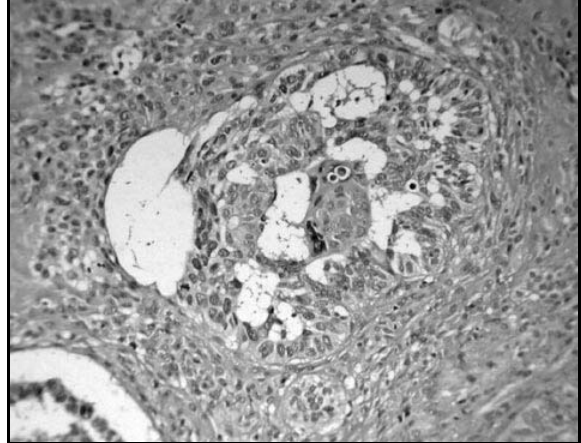
Figura 3 – Detalhe do componente epitelial maligno, esboçando arranjo glandular (H&E, 400x)